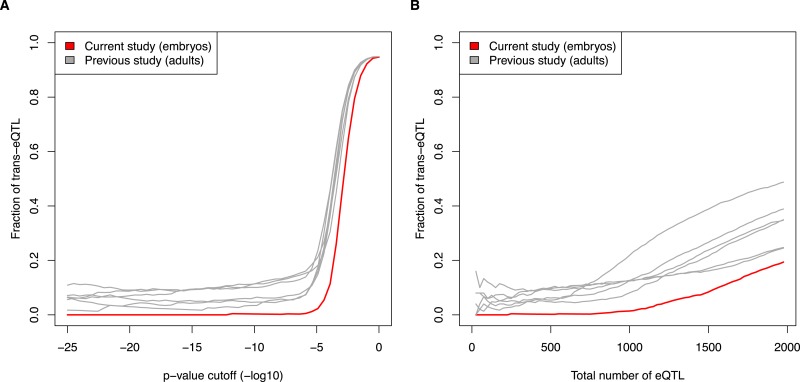
Fraction of eQTL in trans, comparing current embryo study to previous adult studies. (A) eQTL were calculated at increasing p-value cutoffs (x-axis). (B) eQTL were compared at increasing ranks (e.g., top 500 eQTL from each study). See also Figure 5E and 5F.